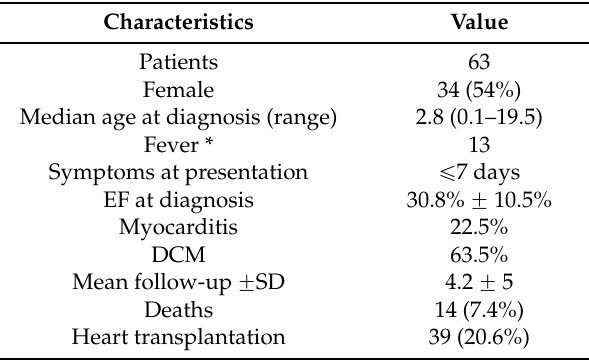
Table 1. Characteristics of the population